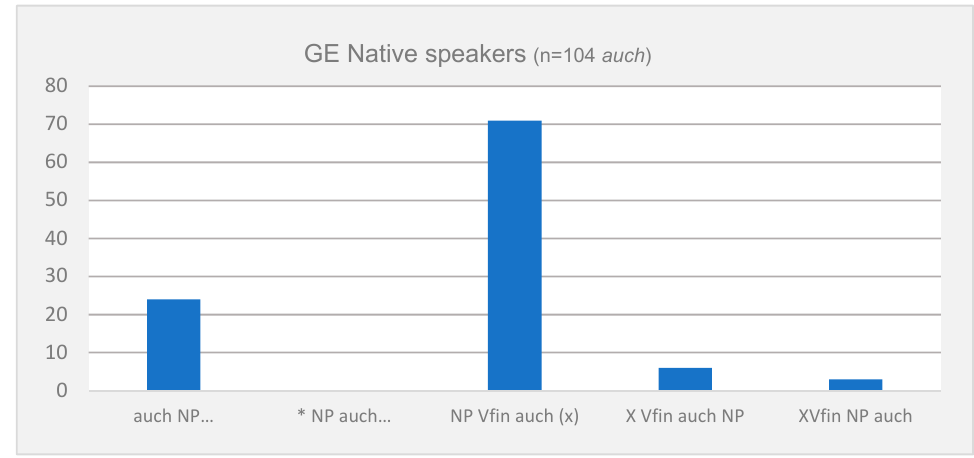
Figure 4. Distribution of additive auch in the utterance (* = agrammatical position in the TL). As expected, auch is most frequently placed after the finite verb (71 occurrences), as in (7a). However, there is also a consistent number of occurrences (24 occurrences) where it immediately precedes the initial NP (7b).